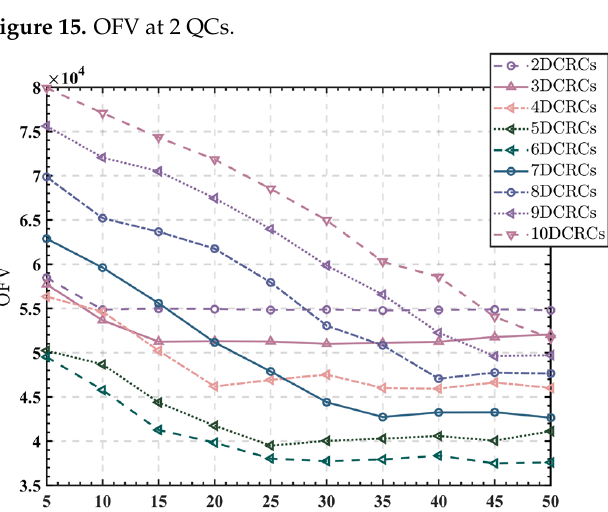
Figure 16. OFV at 3 QCs.